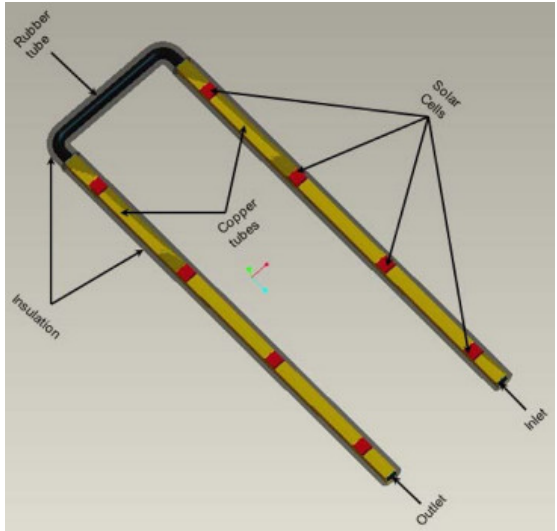
Figure 21. Model of designed receiver [104]. Reprinted with permission from Ref. [104]. 2015, Else- vier.